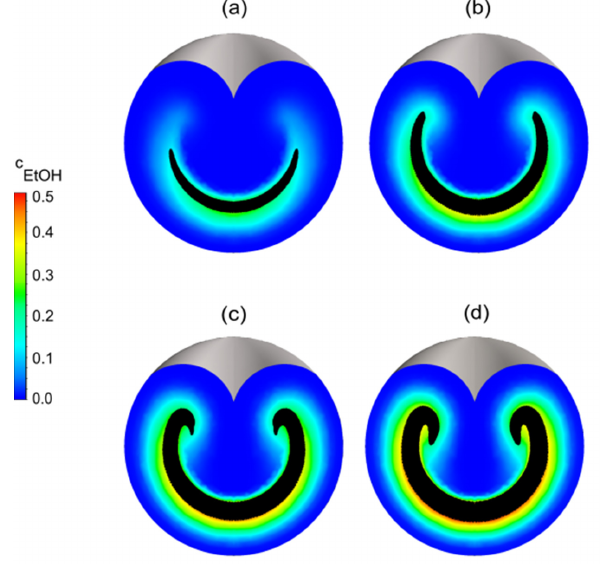
Figure 7. Concentration distributions (color coded) of ethanol 𝑐 (cid:2889)(cid:2930)(cid:2899)(cid:2892) at the third plane placed be ‐ hind the first stretch ‐ and ‐ fold unit for varied flow rate ratios: ( a ) 5%, ( b ) 10%, ( c ) 15% and ( d ) 20%. As in previous figures, the concentrations of ethanol resulting from convection and diffusion are color coded. The black colored areas, however, indicate the area occupied by the solvent when ne ‐ glecting diffusion as obtained by streamline simulation. Note that at the lower flow ratios, too few streamlines are generated in the upper half of the cross sections to become recognizable as very thin black areas.